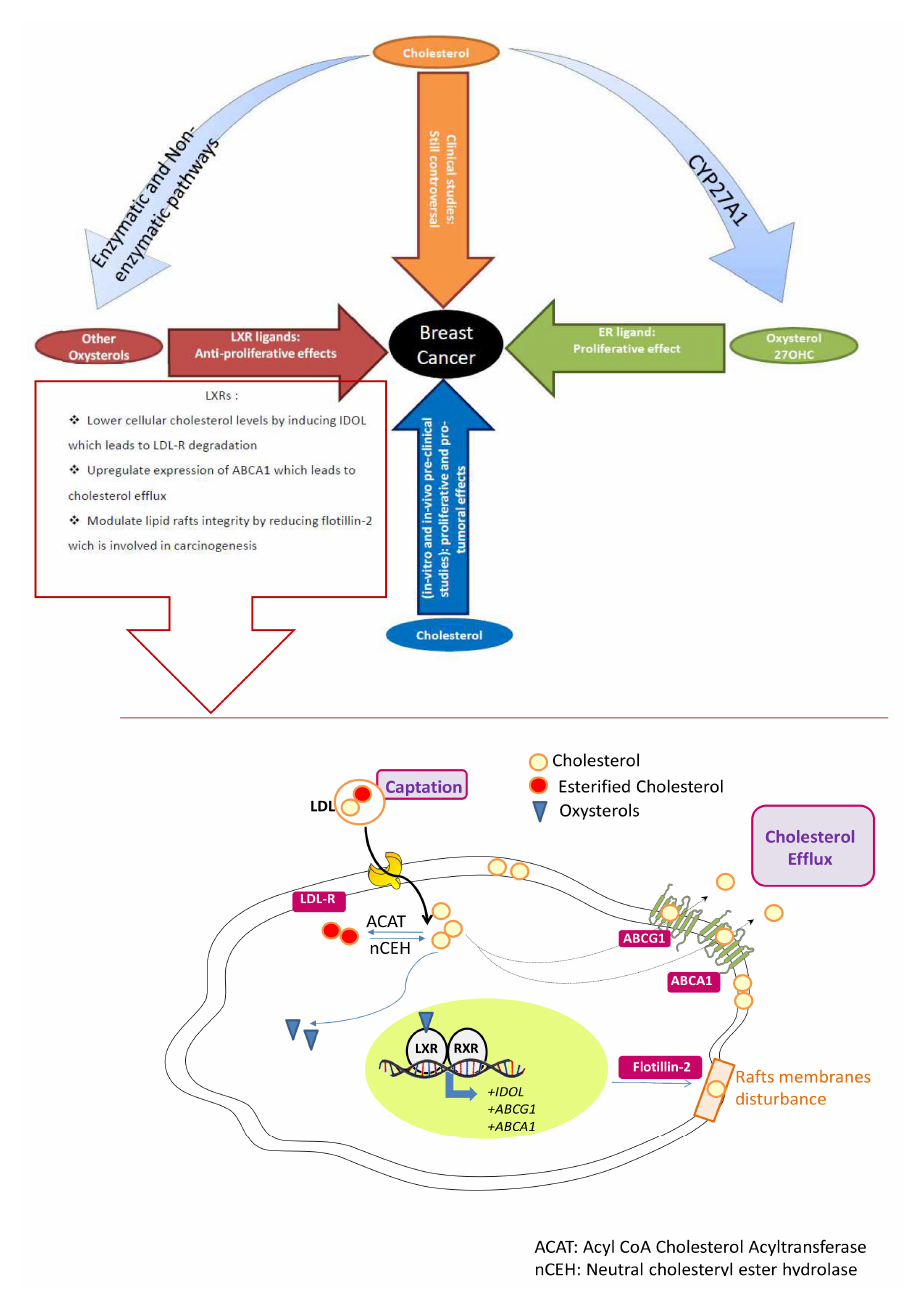
Figure 1. Influence of cholesterol, oxysterols and liver X receptors (LXRs) on breast cancer pathophysiology.